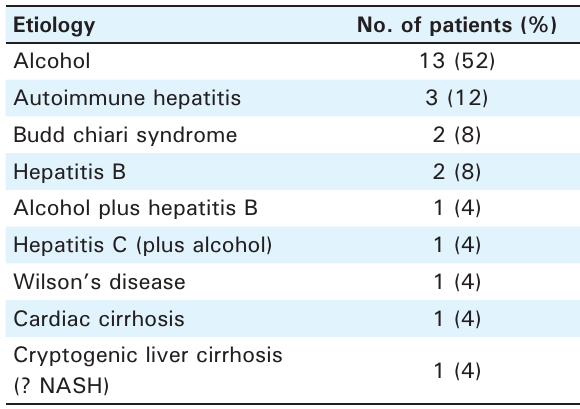
Table 2. Etiologies of chronic liver disease in